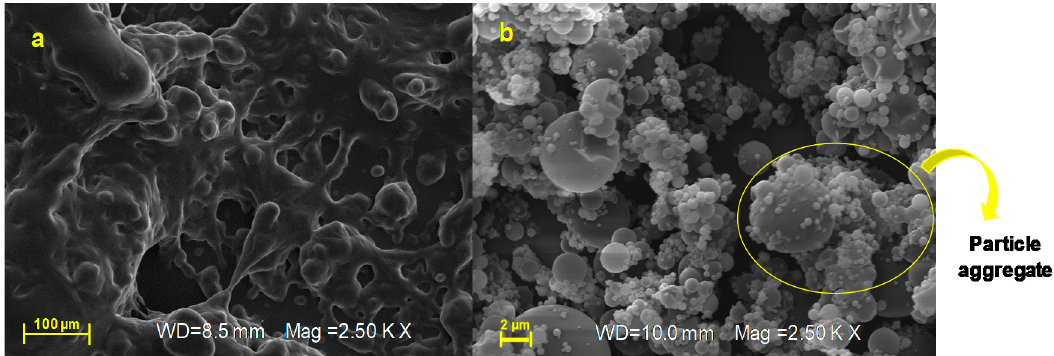
Figure 8. SEM micrographs (magnification: 2.5 KX, frame average, n = 1) of raw extract (AJ, ( a )) and loaded powder (AJEP 3 , ( b )) after six months (t 6months ) of harsh storage condition.